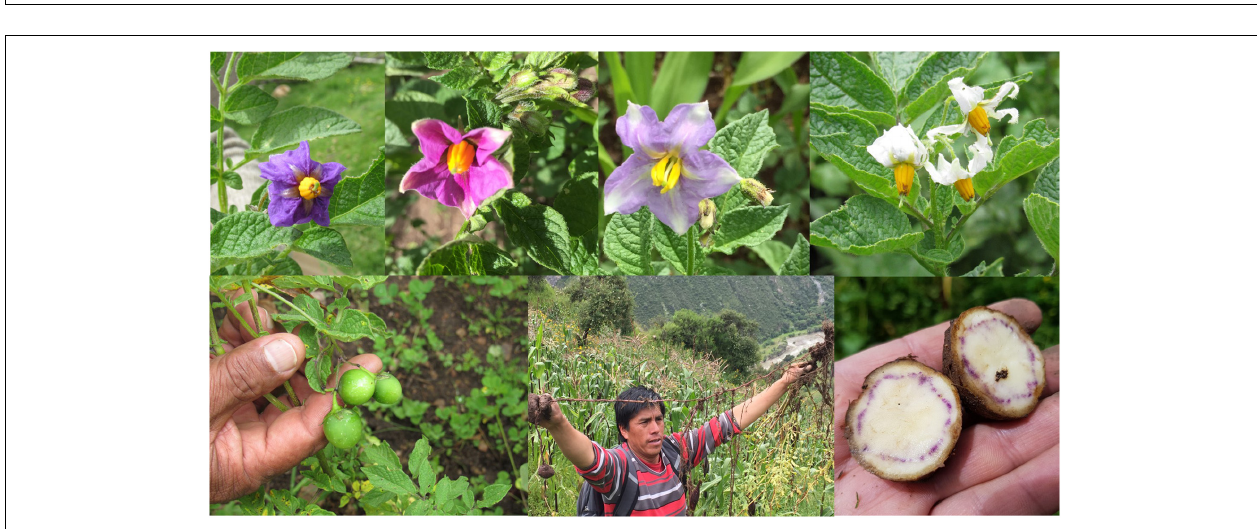
FIGURE 3 | The Quiñota Araq papa Fair. Aspect of the fair showing the high variation of araq papa commercialized and interchanged among people of region. It can be noticed that some of the varieties recorded in this study are shown and commercialized in the fair.